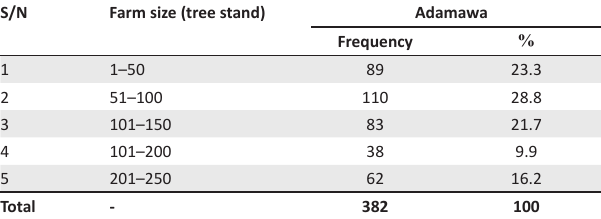
FIGURE 10: Land cover and/or land use affected by 2002 flooding in Adamawa. TABLE 2: Farm size of affected tree crops.